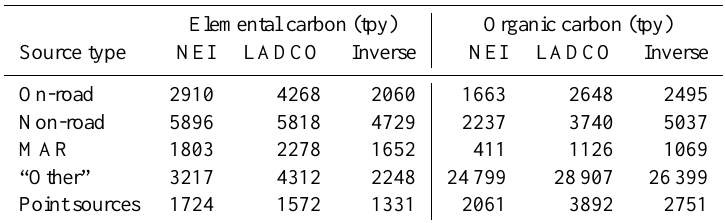
Table 1. Emission totals for EC and OC for the Regional domain around St. Louis by source category for the National Emissions Inventory (NEI), the LADCO inventory and the least squares inverse model. Note that OC Inverse totals combine primary emissions and secondary formation. (MAR = marine, aircraft and railroad.)